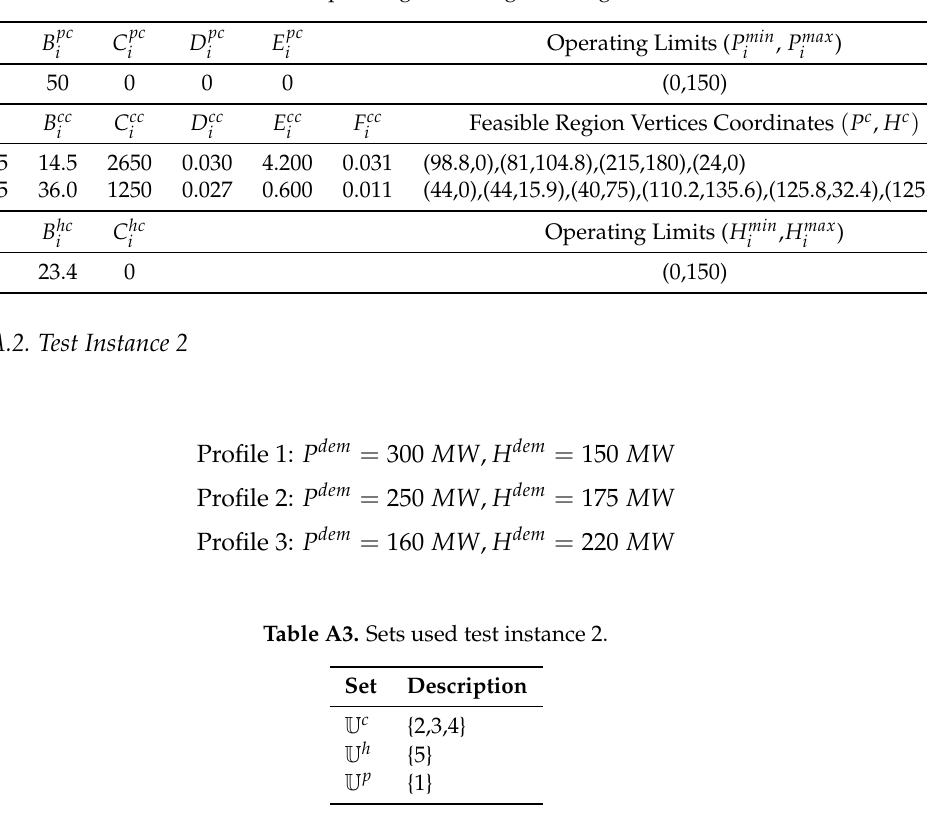
Table A2. Cost functions and operating limits of generating units for test instance 1.